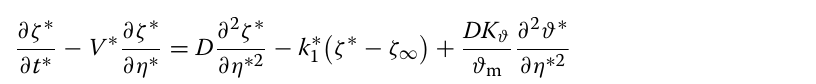
Fig. 1 Geometry of the